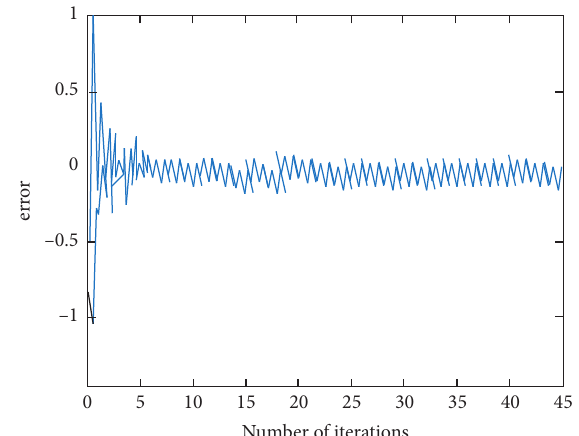
Figure 5: Error caused by the number of